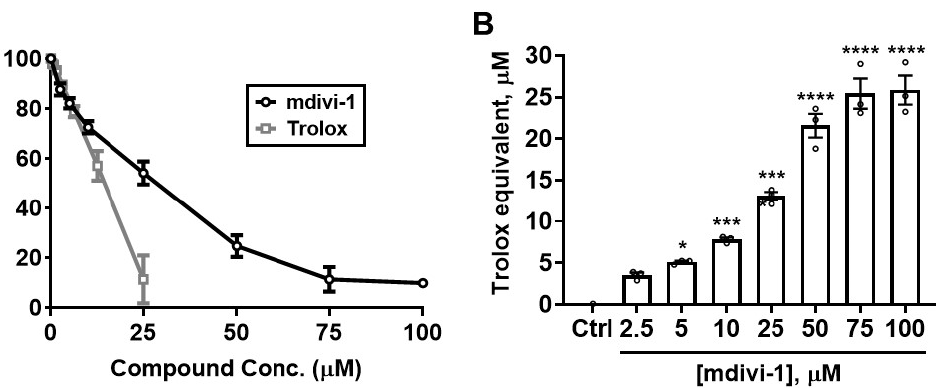
Figure 2. Mdivi-1 dose-dependently depletes ABTS •+ . ( A ) Mdivi-1 (2.5–100 μ M) or Trolox (0.78–25 μ M) was added to ABTS •+ and antioxidant activity was monitored by the ABTS •+ decolorization assay as a decrease in optical density (O.D.), expressed as a percentage of the initial O.D. Each value is depicted as the mean ± SEM; n = 3 separate experiments. ( B ) Trolox-equivalent antioxidant capac-